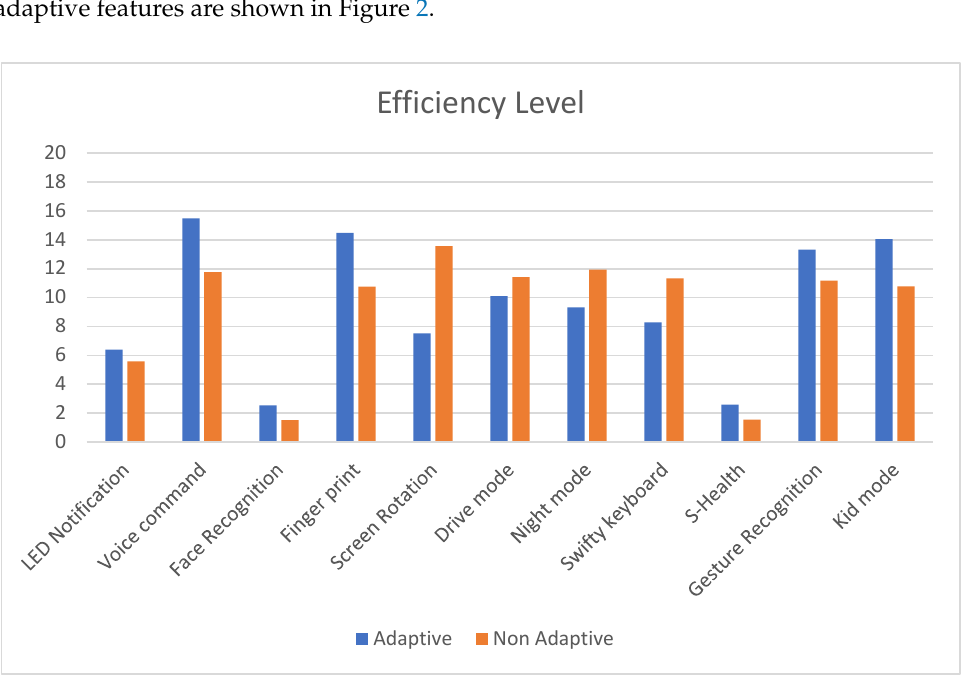
Figure 2. The efficiency levels of adaptive and non ‐ adaptive features.